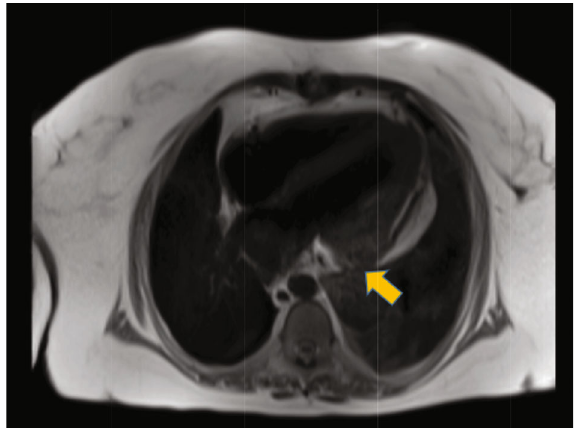
Figure 2: Cardiac magnetic resonance view of the contained left ventricle free wall rupture.